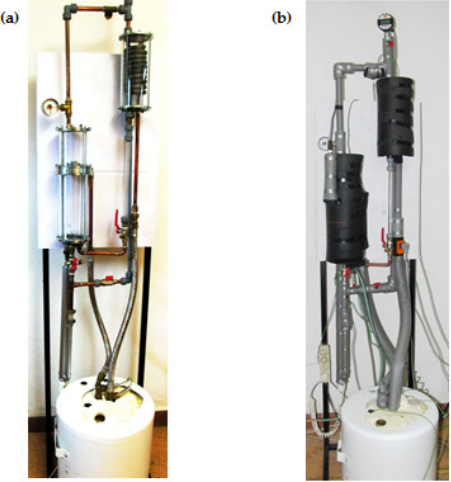
Figure 9. Laboratory test stand: ( a ) without thermal insulation; ( b ) with thermal insulation.